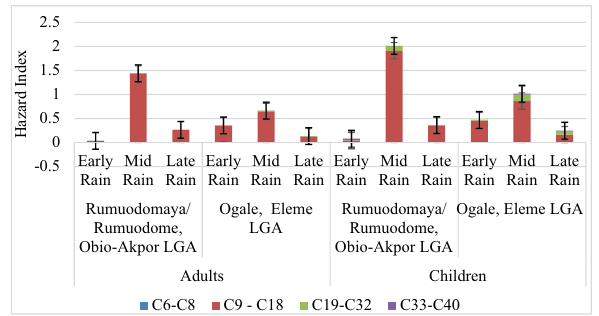
Figure 2. Hazard index of adults and children for aliphatic petroleum hydrocarbons.